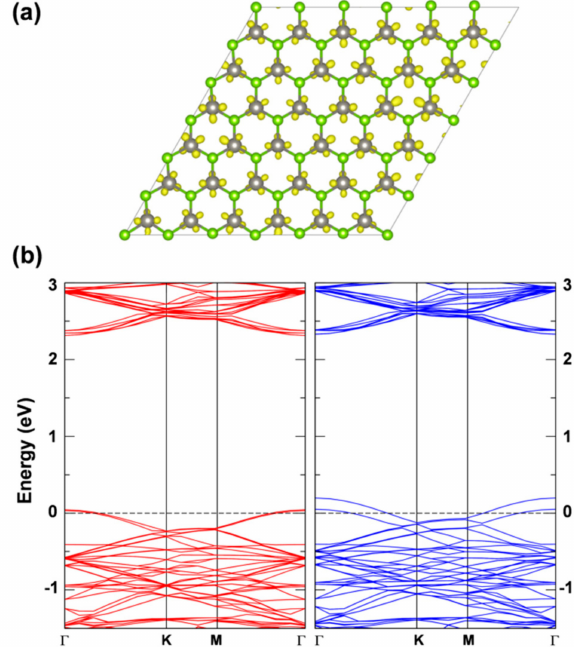
Figure 7. ( a ) Spin density and band structure of the 6 × 6 supercell WSe 2 monolayer with one hole obtained by HSE06/CRY14. In ( a ), the isosurface level is 0.006 electron/bohr 3 ; In ( b ), red and blue lines represent the spin up (majority) and spin down (minority) bands. The Fermi level is scaled to zero.